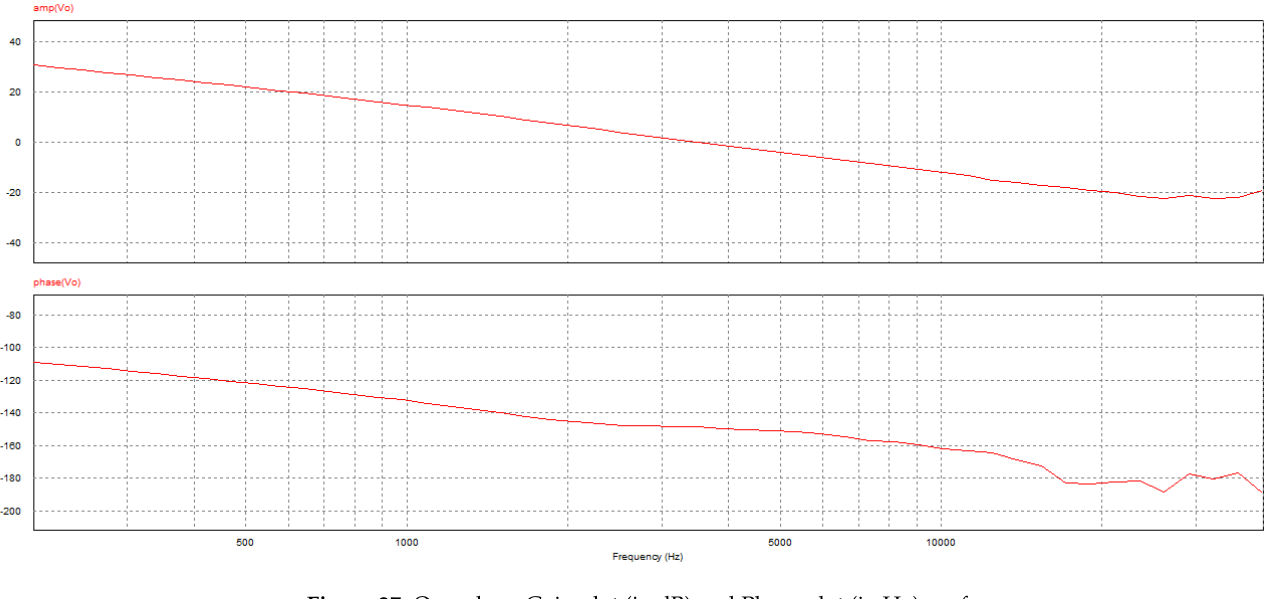
Figure 27. Open-loop Gain plot (in dB) and Phase plot (in Hz) vs. frequency.